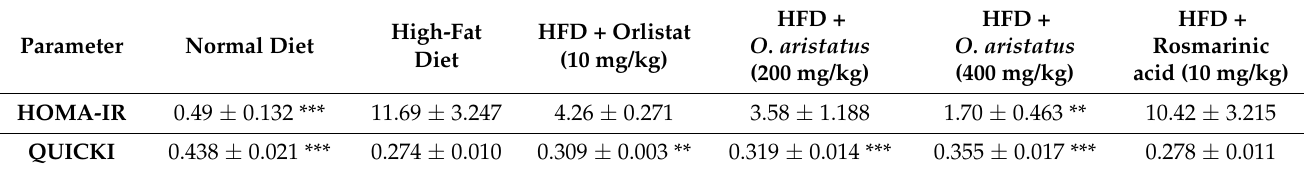
Table 3. The insulin-resistant (HOMA-IR) and sensitivity (QUICKI)